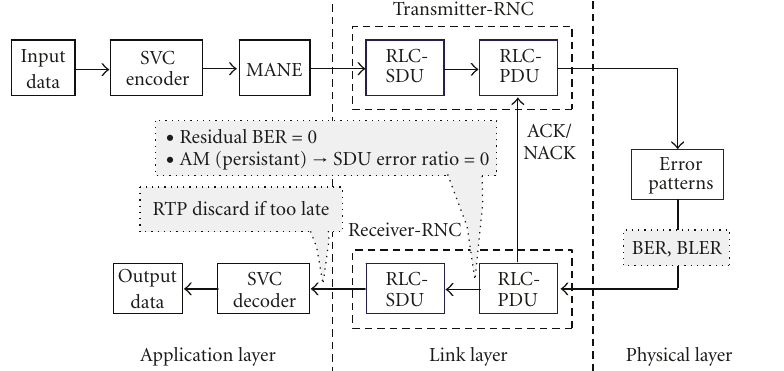
Figure 7: Simulation model.